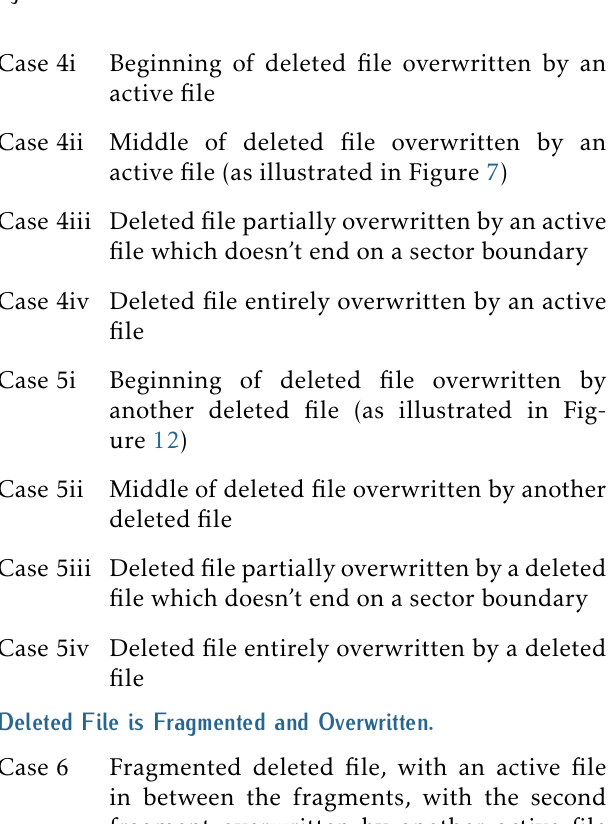
Figure 7. Test Case 4ii. Deleted file A is partially overwritten by active file